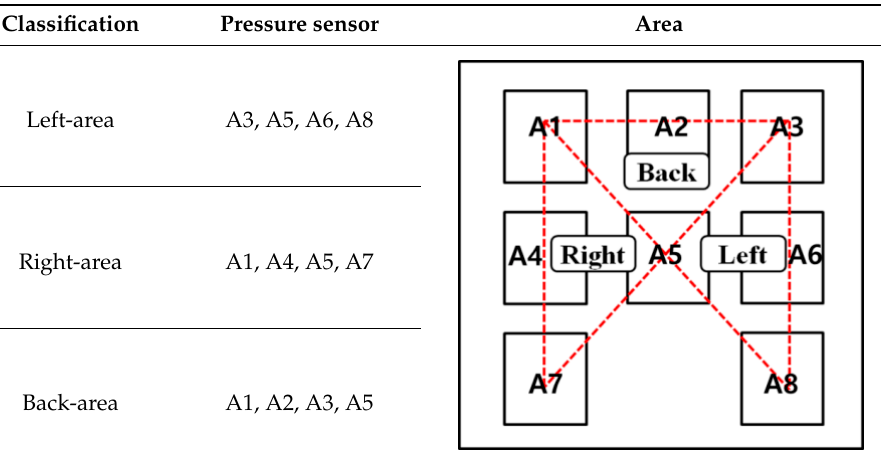
Table 1. Area division according to pressure distribution.